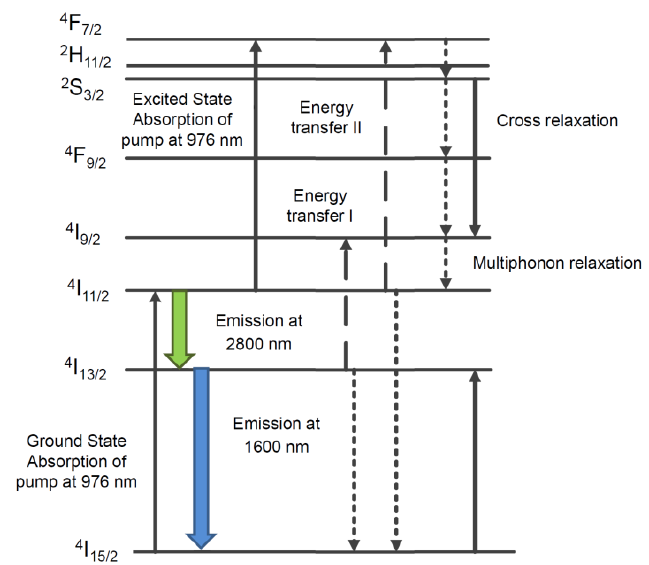
Figure 6. Scheme for the erbium doped fluoride fiber laser based on the cascade of the two transitions 4 I 11/2 → 4 I 13/2 at 2.8 μm and 4 I 13/2 → 4 I 15/2 at 1.6 μm. Figure adapted from [27].